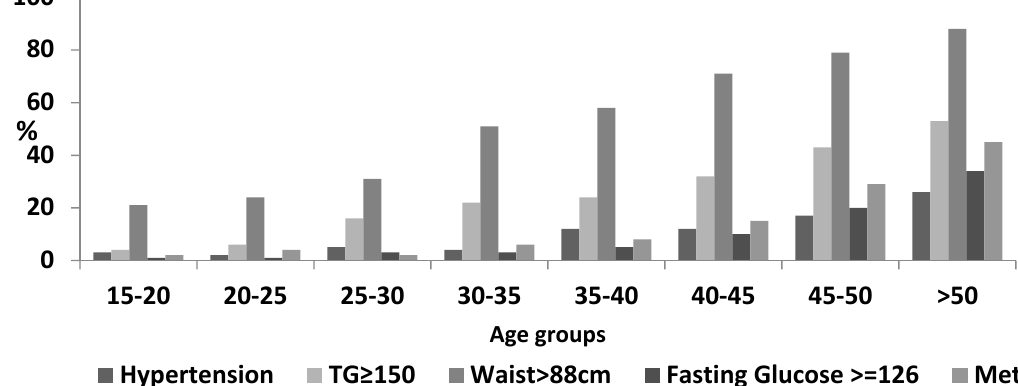
Figure 1. Prevalence of metabolic syndrome and its components by age groups. TG: triglycerides; MetS: metabolic syndrome.